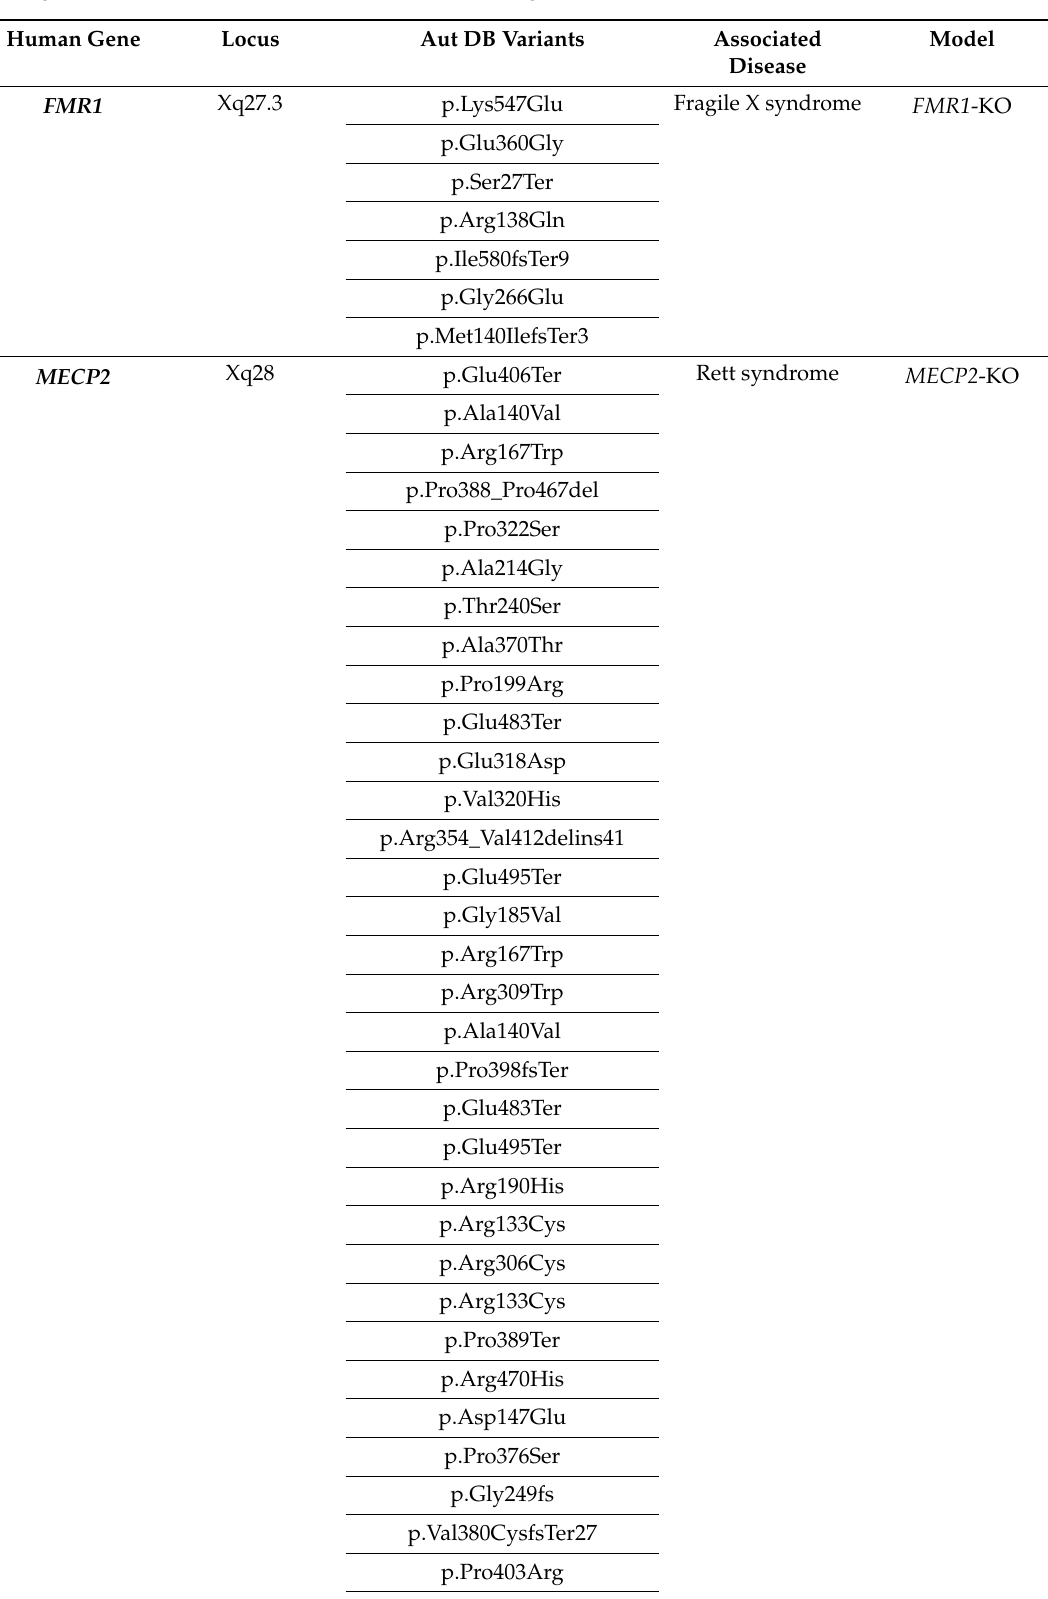
Table 1. Genes associated with autism spectrum disorder (ASD) for which a Knock-Out model is provided. The column variants are “ AutDB variants ”, including the variants in the protein-coding region that is AutDB-related and with a familial